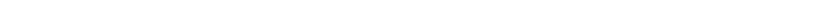
ranking is not discriminatory, and all top scorers should be examined. We combined the two screens, merged stereoi- somers, and found 16 candidates which give promising binding models (etoposide and its phosphate counted as one) (Table 3). One drug (dirlotapide) which is not intended for human use was excluded. All possible isomers of compounds with multiple stereoisomers are found in the full screening results of 1500, in particular: 38 of hesperidin, 34 of teniposide, 32 of etoposide and 21 of